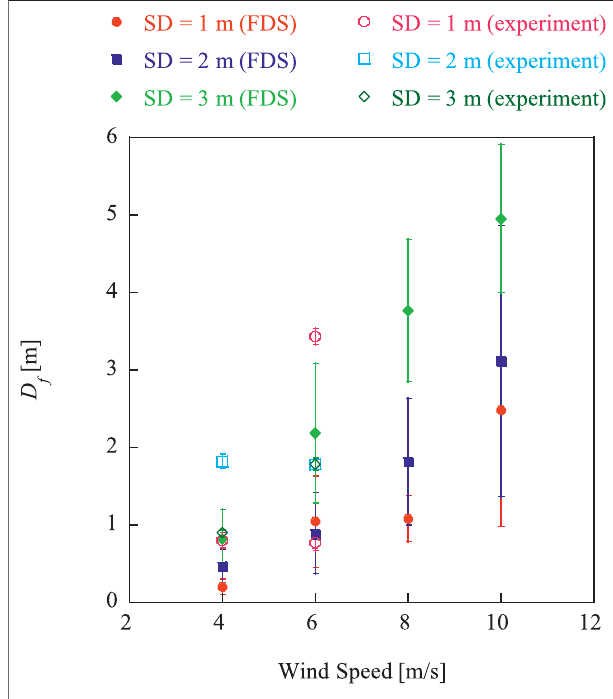
FIGURE 12 | Comparison between average distance from a stagnation zone(windspeed2.3ms -1 )fromastructurefrontinFDSsimulationandthose in